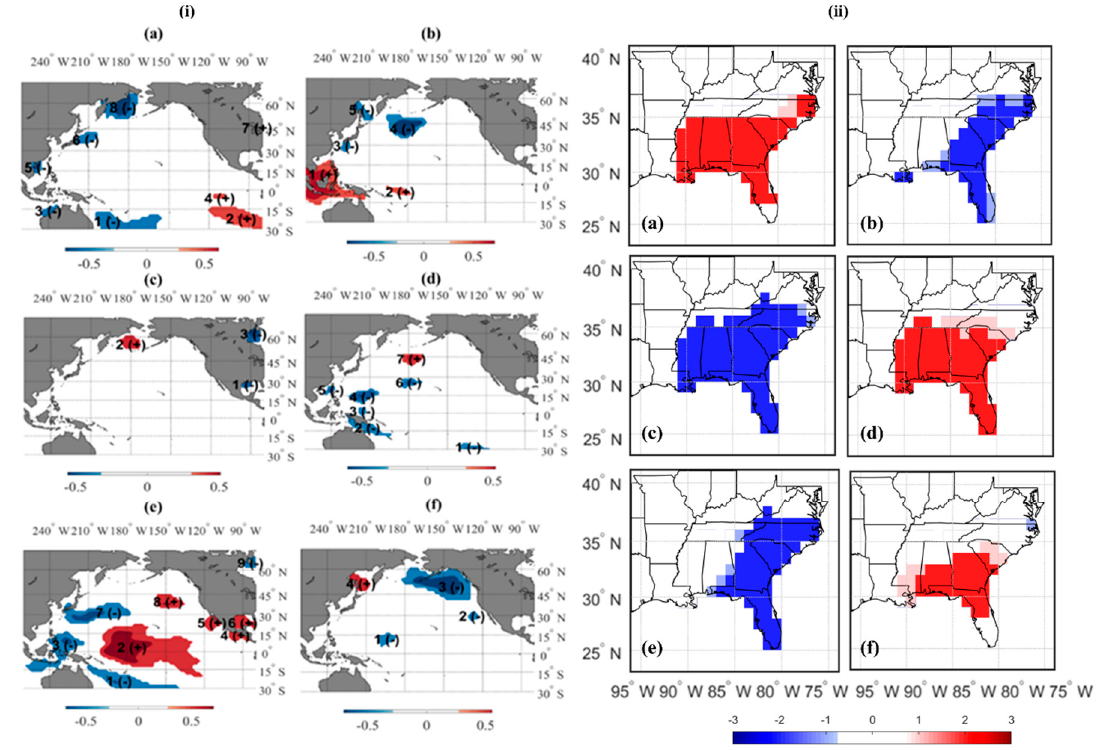
Figure 5. Heterogeneous correlation patterns between ( i ) Pacific Ocean SST and ( ii ) gridded PPT of the HUC-03 watershed region. ( a ) June-SST Aug-PPT; ( b ) July-SST Sept-PPT; ( c ) Aug-SST Oct-PPT; ( d ) Sept-SST Nov-PPT; ( e ) Oct-SST Dec-PPT; and ( f ) Nov-SST Jan-PPT.